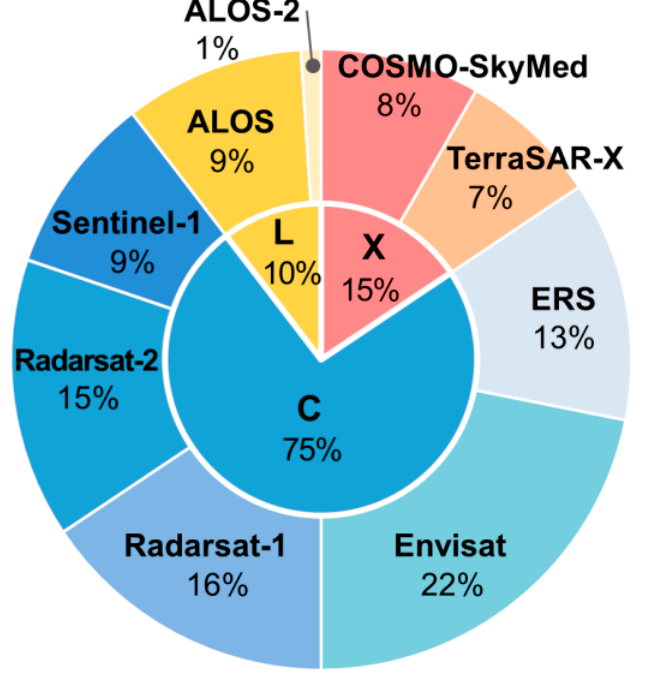
Figure 3. The frequency of different SAR sensors/bands being employed for snow cover studies.